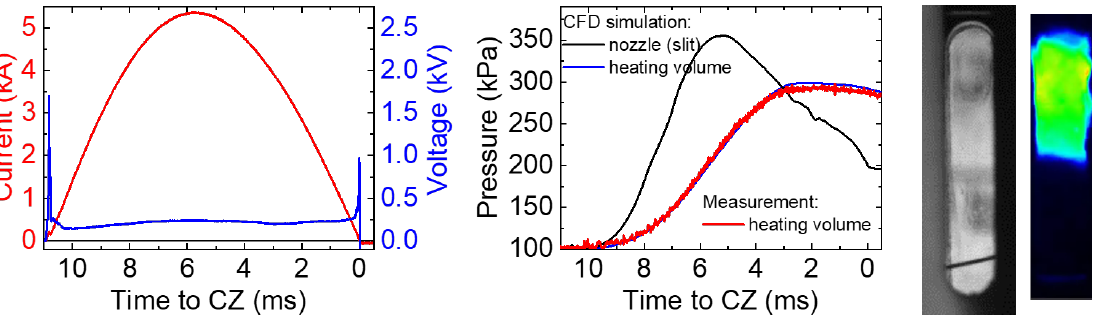
Figure 3. Left : Current and voltage waveform—nearly a sine 50Hz shape and duration ( ∼ 10.6ms). Middle : Pressure simulation for two positions and measurement for heating volume. Right : Photo (grey) of window with ignition wire and example for observation of the general behavior of the discharge about 1ms before current zero (CZ) (false color representation) showing an asymmetric position of a constricted